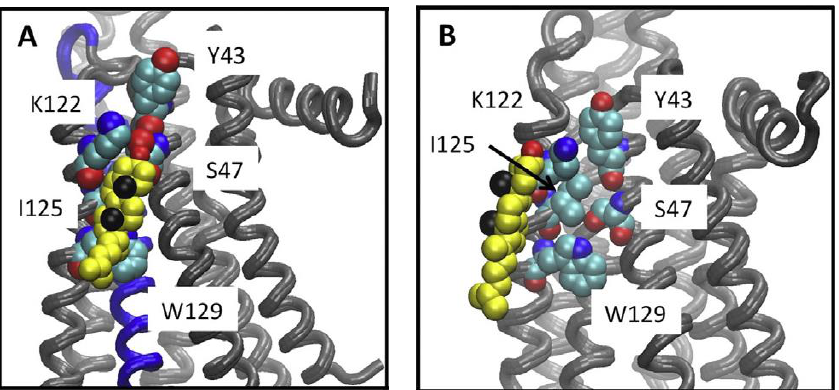
Figure 1. Cholesterol association to the A 2A R CCM. Cholesterol bound to the CCM during simula- tions. ( A ) A snapshot from the UK432097-bound simulation, showing the disposition of cholesterol (yellow, black spheres show the methyls of the beta face and red the hydroxyl) relative to the CCM (shown in space filling representation) in a tightly bound configuration. ( B ) The closest approach obtained between cholesterol and the CCM in any of the inactive receptor simulations (snapshot from ca. 0.8 μsec of the ZM241385 bound simulation. Figure is adapted reprinted with permission (license #5316530596446) from McGraw et al. [12]. Copyright 2019, Elsevier B.V.